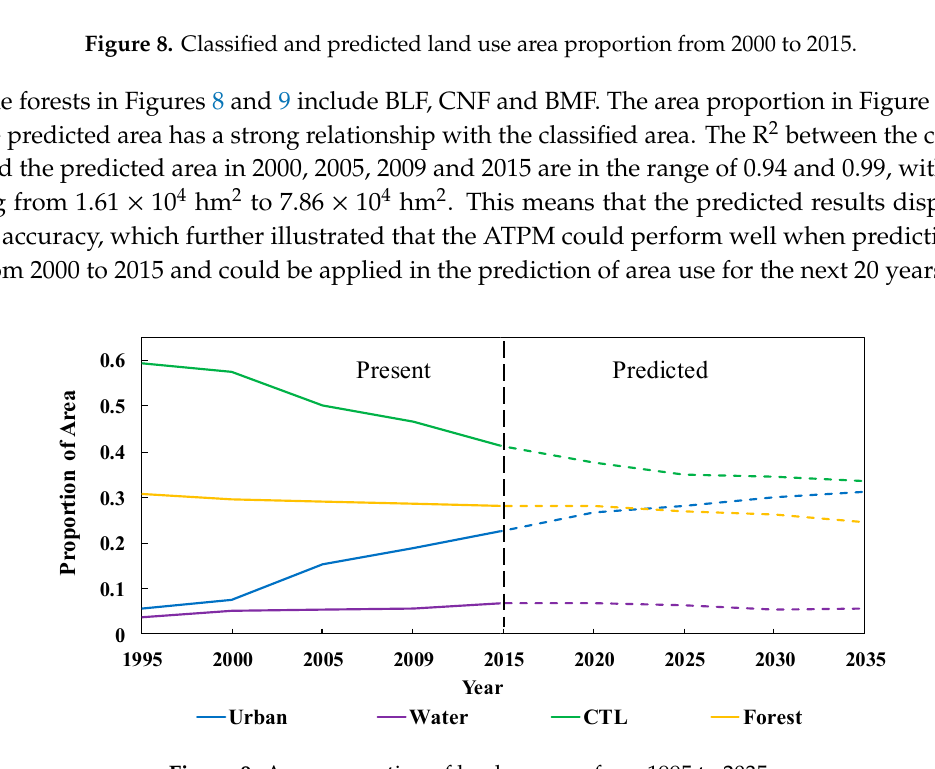
Figure 8. Classified and predicted land use area proportion from 2000 to 2015.